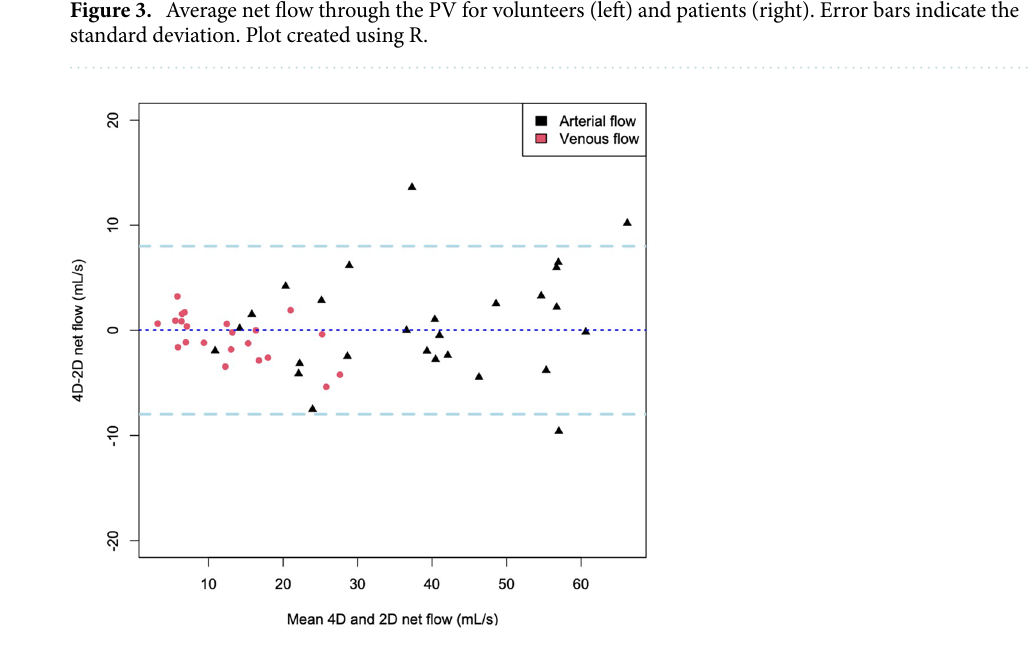
Figure 4. Bland–Altman results of 2D and 4D average flow for all analysis planes. Plot created using